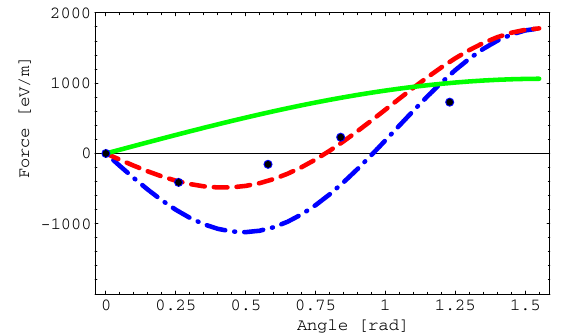
FIG. 9. (Color) Transverse component of the force at ion veloc- (cid:5) 1 : 1 (cid:6) 10 7 m = s , (cid:1) (cid:5) 1 : 0 (cid:6) 10 5 m = s , ity 6 (cid:6) 10 5 m = s ( (cid:1) e; ? e; k B (cid:5) 5 T ): gray dot-dashed line—Eq. (6); blue dashed line— Eq. (4).